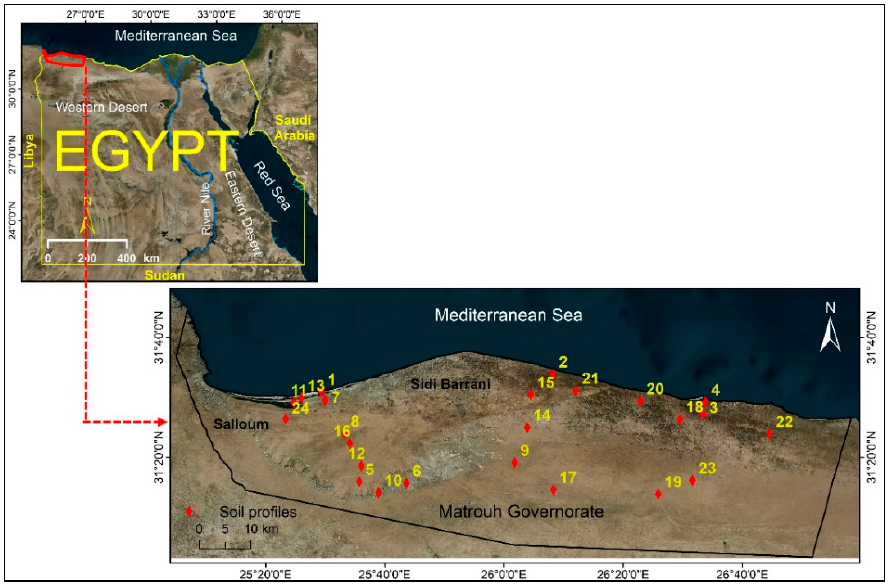
Figure 1. Location of the study area in northwestern Egypt and the soil profiles with a red dot.